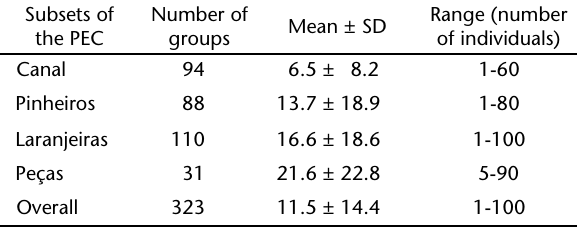
Table I. Group size of S. guianensis observed in four subsets of the Paranaguá Estuarine Complex (PEC) from April 2006 to July 2008. Subsets of the